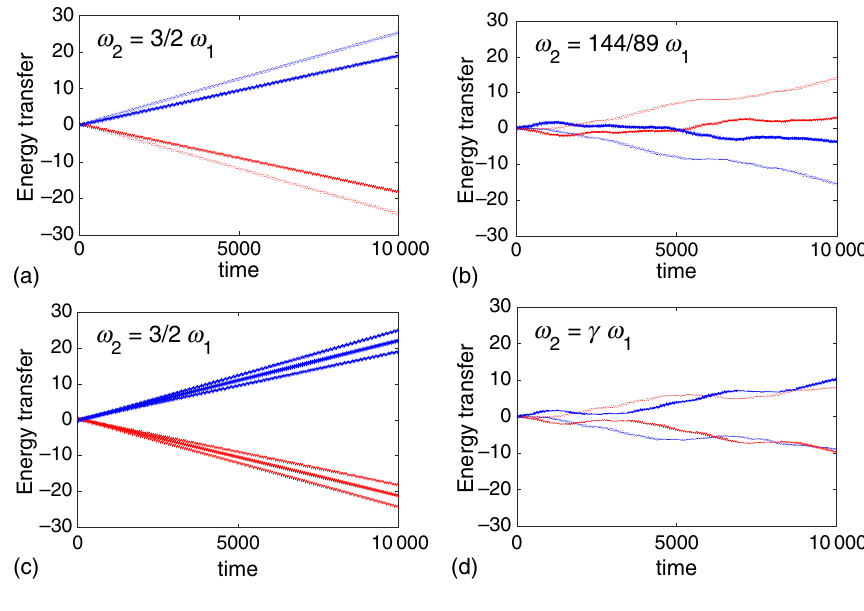
FIG. 11. Same as Fig. 10, but for η ¼ 0 . 5 .